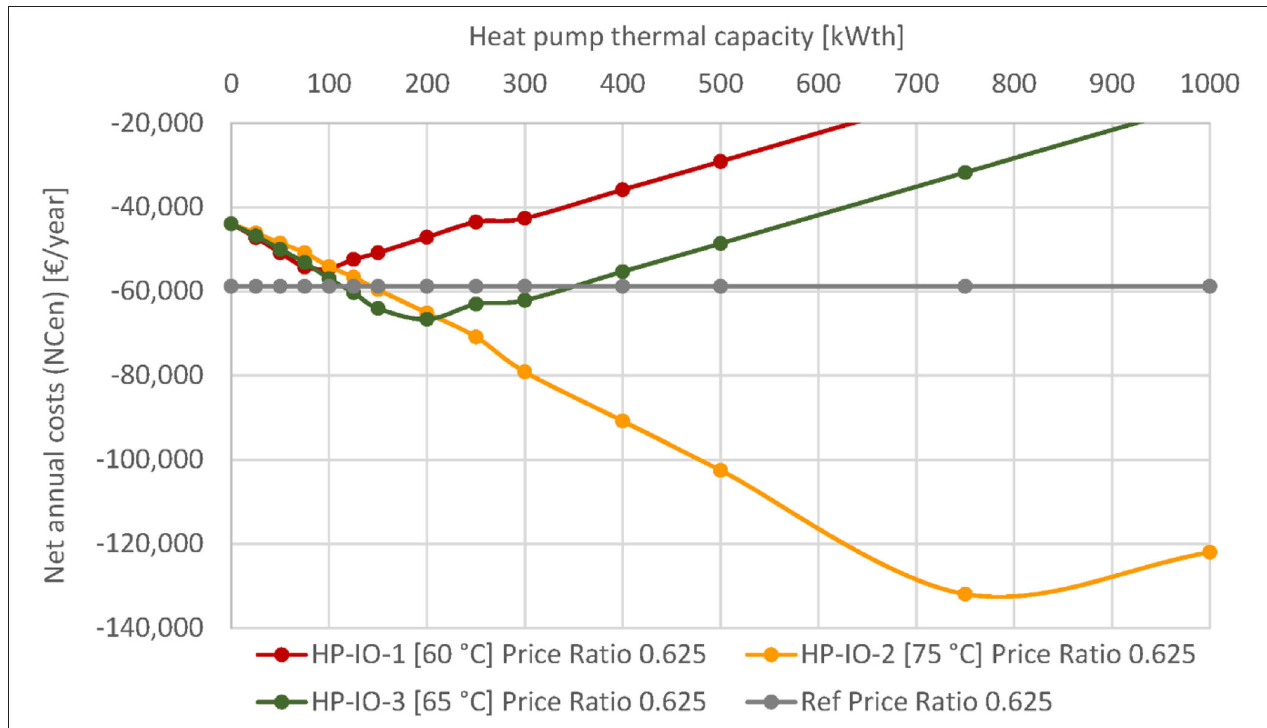
FIGURE 9 | Net annual costs ( NC En ) of three heat pump integration options at price ratio 0.625. Negative net annual costs are net annual